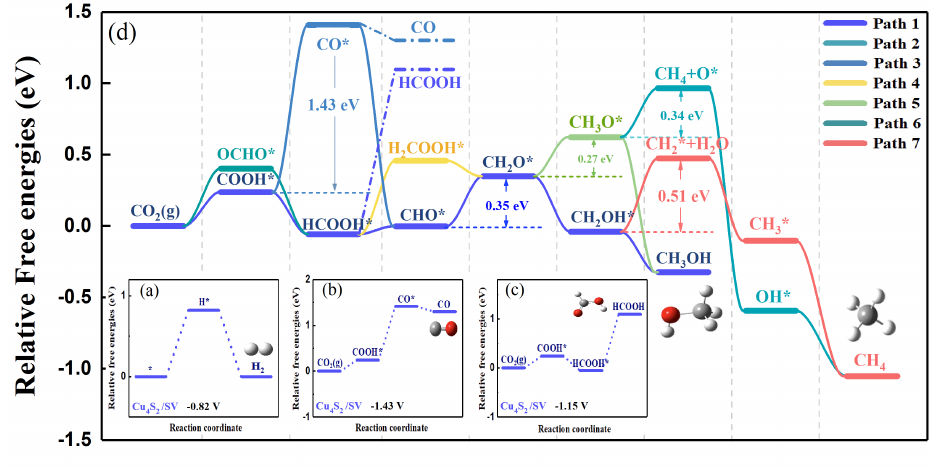
Figure 3. Reaction pathways to produce H 2 ( a ), CO ( b ), and HCOOH ( c ) on the Cu 4 S 2 /SV catalyst with no applied potential. The potential required to carry out over the most endergonic step is listed in the legend. The mechanistic free energy diagram of CO 2 RR on the Cu 4 S 2 /SV catalyst with no applied potential ( d ). The colorful solid lines label thermodynamically feasible reaction pathways, in which each step involves a (H + + e – ) pair transfer. The step of CO or HCOOH desorption (in dashed line) is a thermochemical process that does not involve (H + + e – ) pair